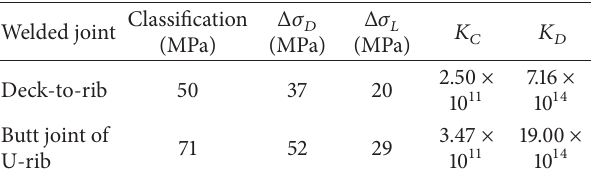
Table 4: Parameters of 𝑆 - 𝑁 curves in Eurocode 3